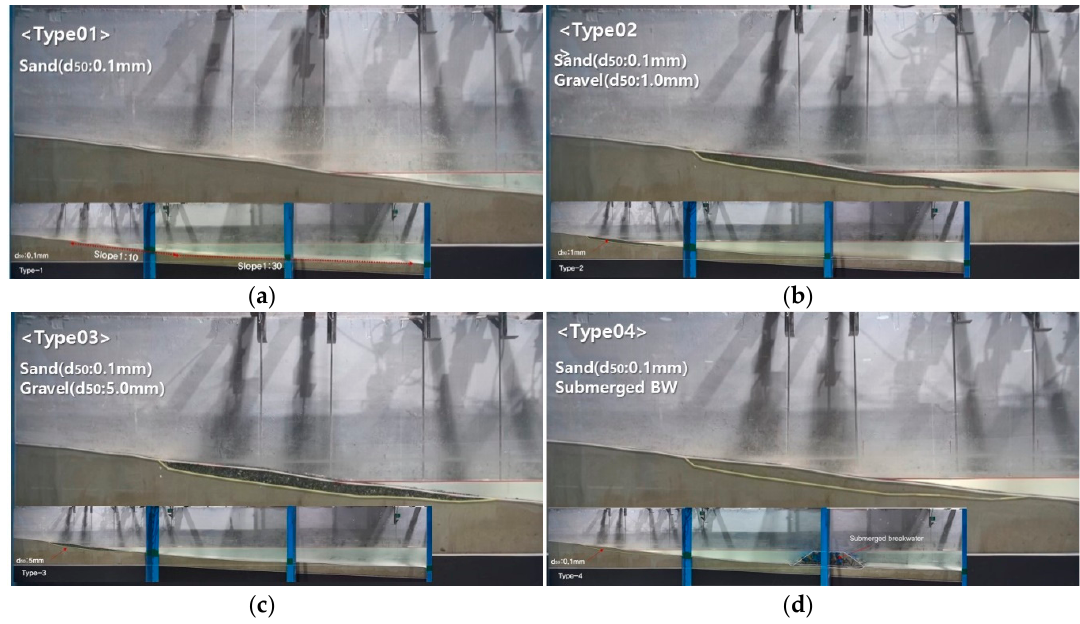
Figure 2. Beach profiles. ( a ) Sand (d 50 : 0.1 mm), ( b ) Sand (d 50 : 0.1 mm), Gravel (d 50 : 1 mm), ( c ) Sand (d 50 :0.1 mm), Gravel (d 50 :5 mm), ( d ) Sand (d 50 :0.1 mm), Submerged BW